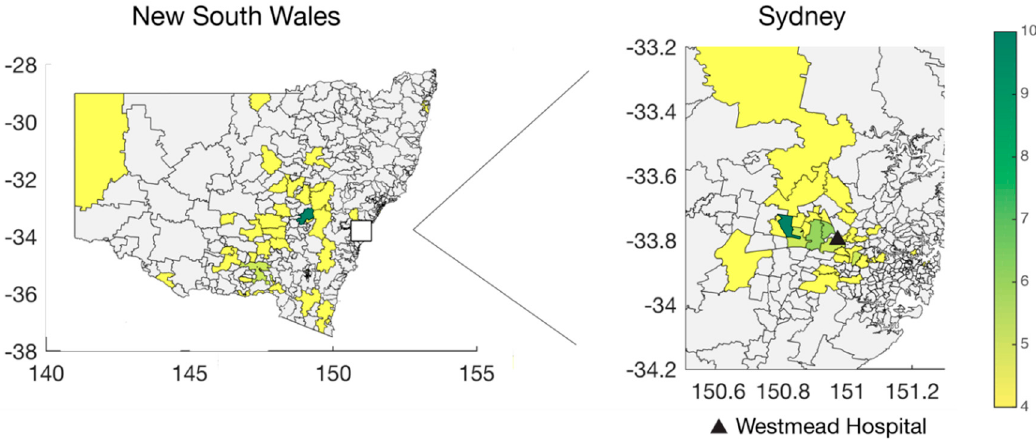
Figure 2. Geographic distribution of respiratory syncytial virus in NSW. Number of sequences per postcode in NSW ( left ) and greater Westmead area ( right ). The location for Westmead Hospital is indicated.